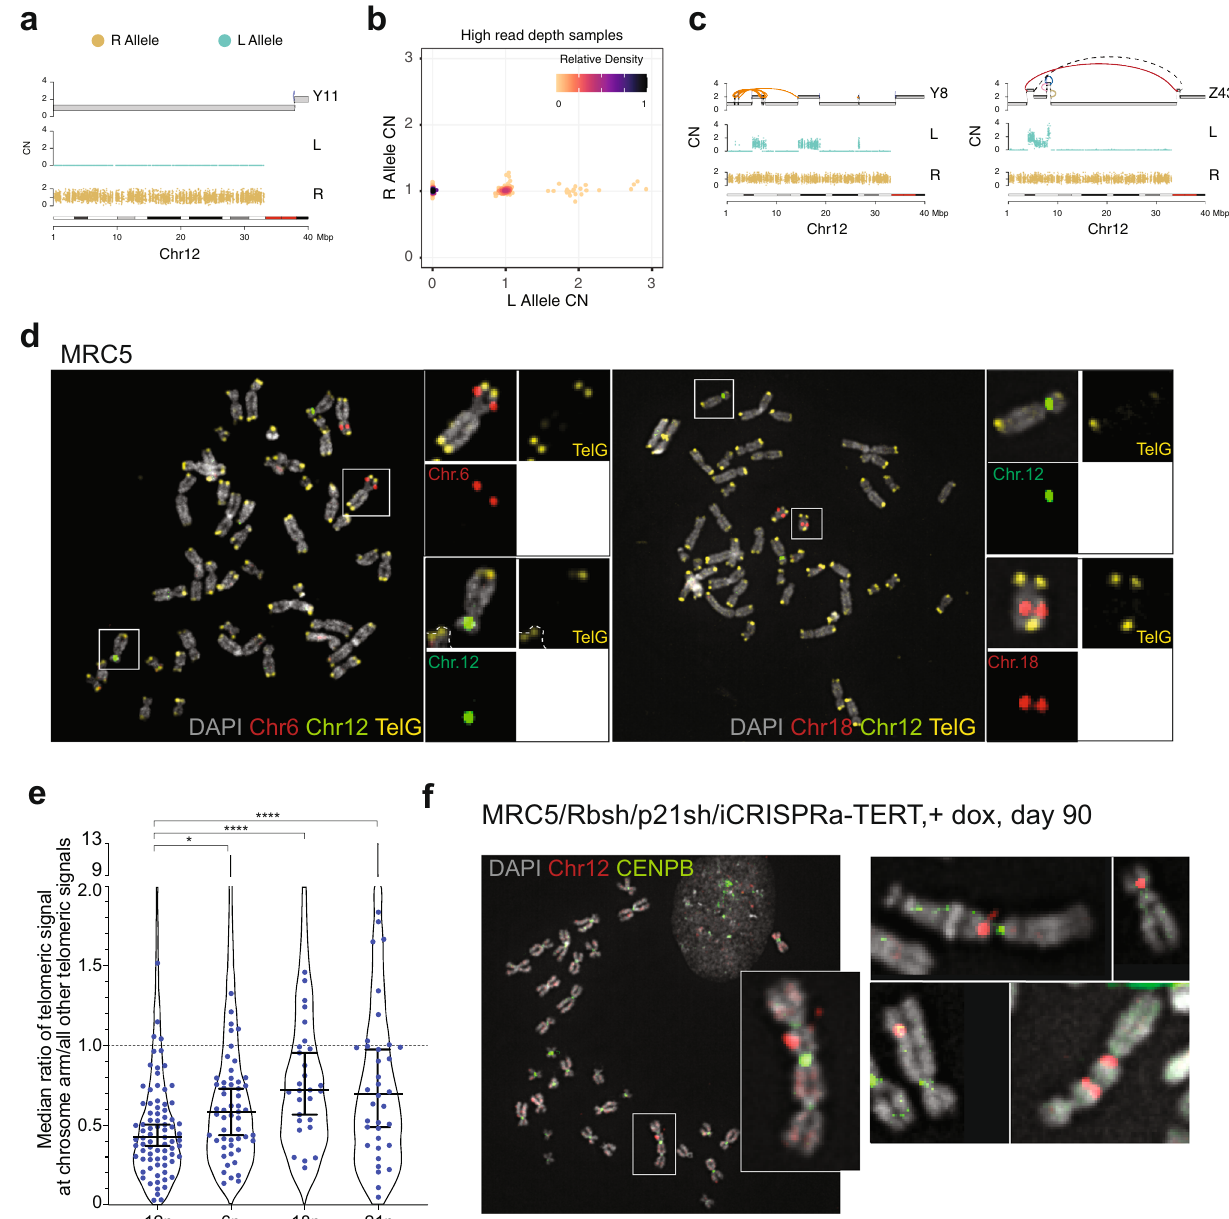
Fig. 7 A short telomere on one allele of 12p. a Genomic track plots of parental alleles phased into lost ( “ L ” ) and retained ( “ R ” ) haplotypes (see “ Methods ” ) on chromosome 12p of clone Y11. b Scatter plot showing purity- and ploidy-transformed L and R haplotype-speci fi c allelic read depth across 12p segments in high-pass WGS-pro fi led post-crisis clones. c Genomic track plots of allelic read counts on the L and R allele of clones Y8 and Z43, two post-crisis clones that independently acquired structural variants on an otherwise unrearranged chromosome 12p allele. d Metaphase spreads of early-passage MRC5 cells hybridized with BAC probes to chromosome 12 (green) combined with probes for chromosome 6 or 18 (red) and a PNA probe for telomeres (TelG, yellow). Insets of white-boxed chromosomes are shown with each channel individually. e Quanti fi cation of the relative length of the shortest of the two 12p telomeres. Each dot shows the median ratio of the TelG signal of the shortest telomeres of the indicated chromosome arm to all other telomeres in each metaphase spread. Violin plots show the data from all telomeres analyzed. Chromosome 12 was identi fi ed using a speci fi c BAC probe (Chr.12p11.2) in 79 metaphase spreads with a total of 3992 telomeres. Chromosomes 6 and 18 were identi fi ed based on BAC probe hybridization (Chr.6p21.2 – 21.3, Chr.18q12.3 – 21.1) in 53 and 28 metaphases, respectively (2629 and 1497 telomeres, respectively). Chromosome 21 was identi fi ed from DAPI banding patterns in 36 metaphases (1757 telomeres). P values were derived from a two-sided Student ’ s t test; * P = 0.0147; **** P < 0.0001. Error bars show median with 95% CI. f Dicentric chromosomes containing chromosome 12 in telomere crisis. Metaphase spreads from MRC5/Rbsh/p21sh/iCRISPRa-TERT cells cultured with doxycycline at day 90 (during crisis) were hybridized with a BAC probe for Chr.12p11.2 (red) and a CENPB PNA probe (green) to identify centromeres. A full spread is shown with white box inset zoom in. Further examples from other spreads are also shown (see also Supplementary Fig.